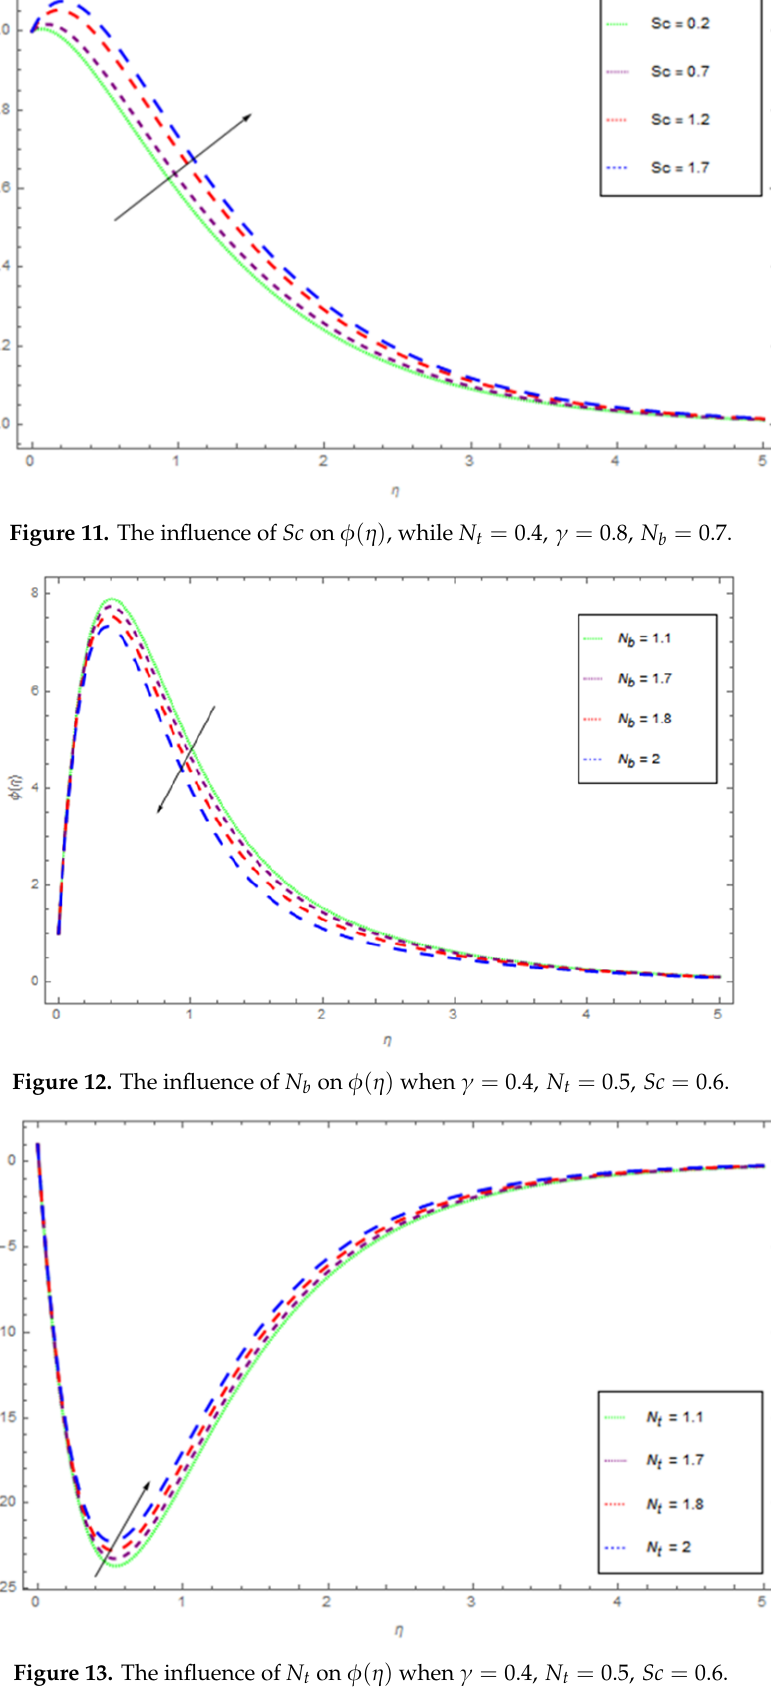
Figure 13. The influence of N t on φ ( η ) when γ = 0.4, N t = 0.5, Sc =